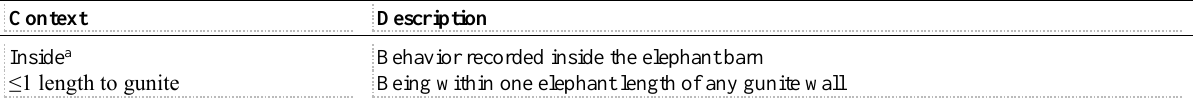
Ethogram Key of Behavioral Contexts Recorded During Nocturnal Observation